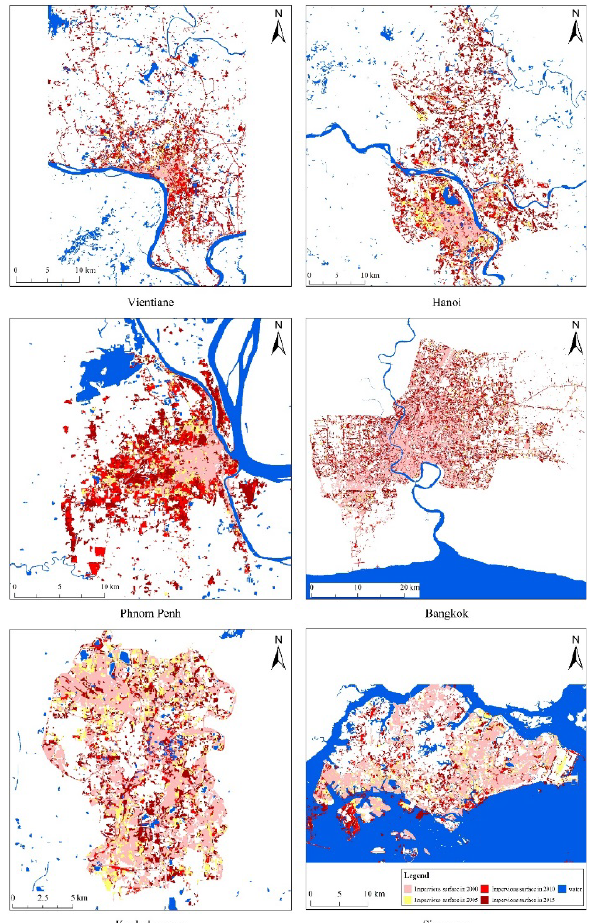
Figure. 4 the extension of impervious